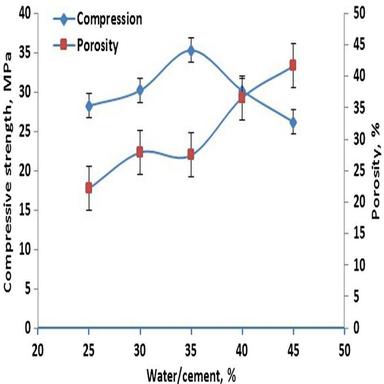
Different water ratios for cement hydration and corresponding mechanical integrity.